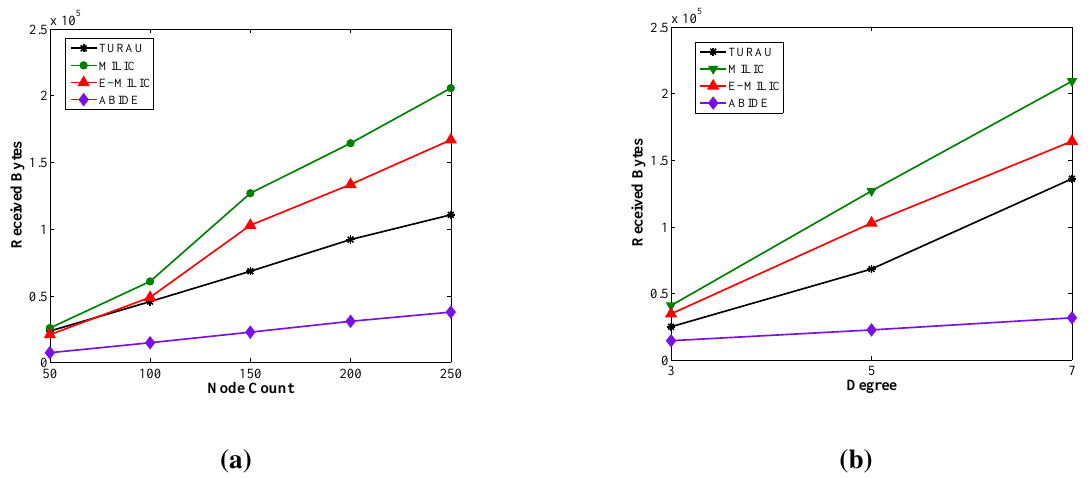
Figure 15. Comparisons between algorithms in terms of received bytes. ( a ) Received bytes against node count; ( b ) received bytes against